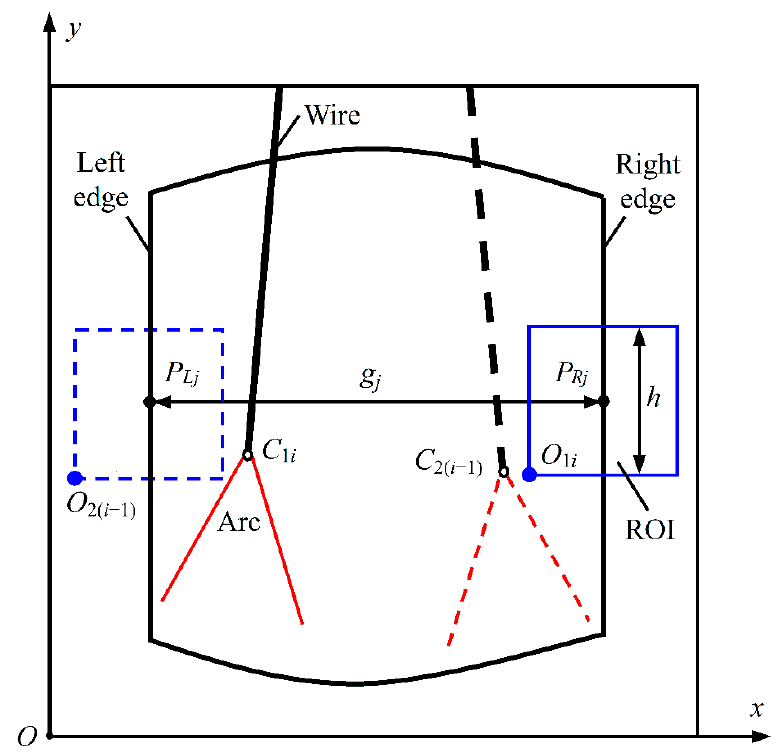
Figure 2. Principle of groove width detection approach for swing arc narrow gap welding.